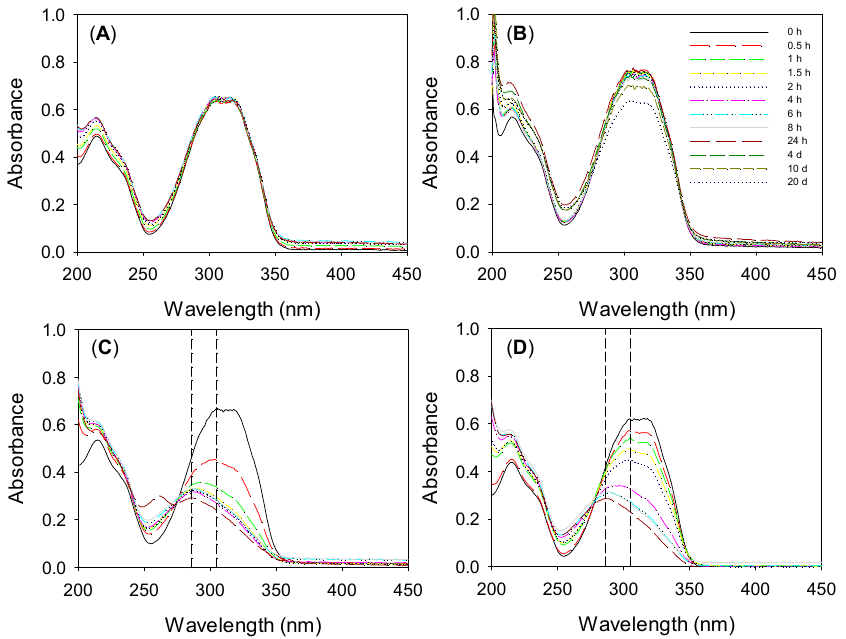
Figure 4. UV–Vis spectra recorded for resveratrol in ethanol:water 10:90 v/v medium ( A ) and resveratrol in NaCl 0.9% ( B ) without light at 36 °C and 180 rpm for several days, and resveratrol in ethanol:water 10:90 v / v medium exposed to white light ( C ) and working area light ( D ) for 24 h. Dashed lines indicate the maximum wavelength of cis -resveratrol (286 nm) and trans -resveratrol (305 nm).